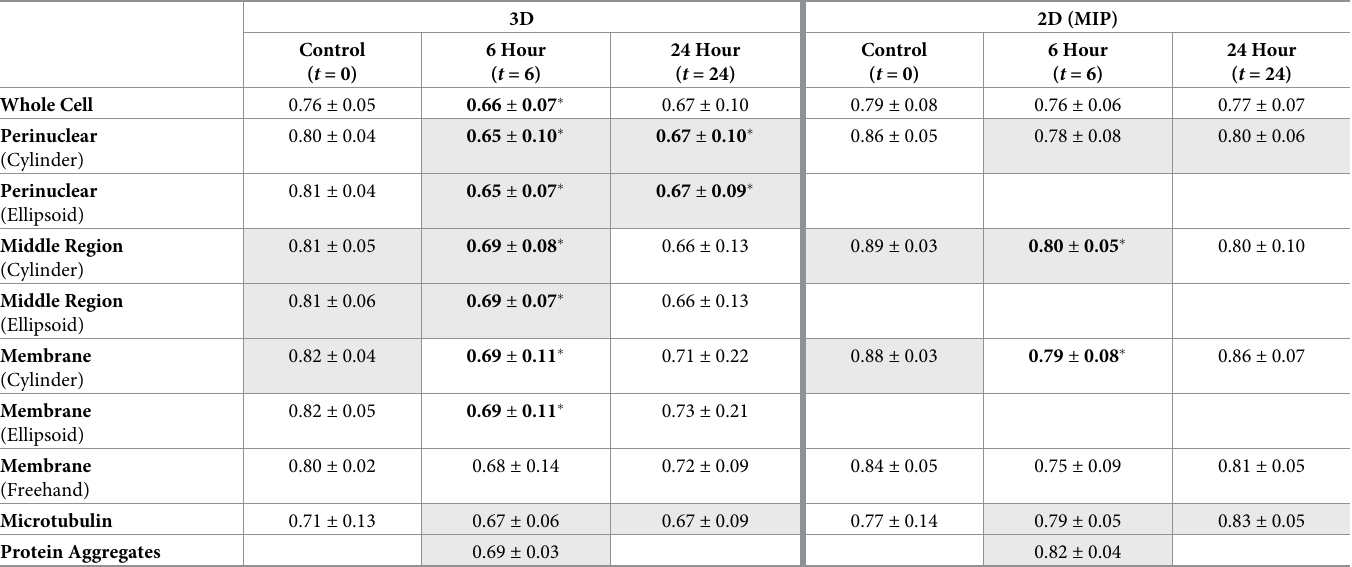
Table 3. Manders’ overlap coefficient with procedure described in Table 2.